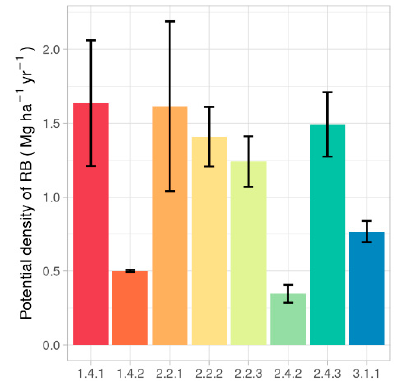
Figure 8. Average potential residual biomass density in each land cover class in the study area. Fill colors of the CLC classes are as in Figure 3.